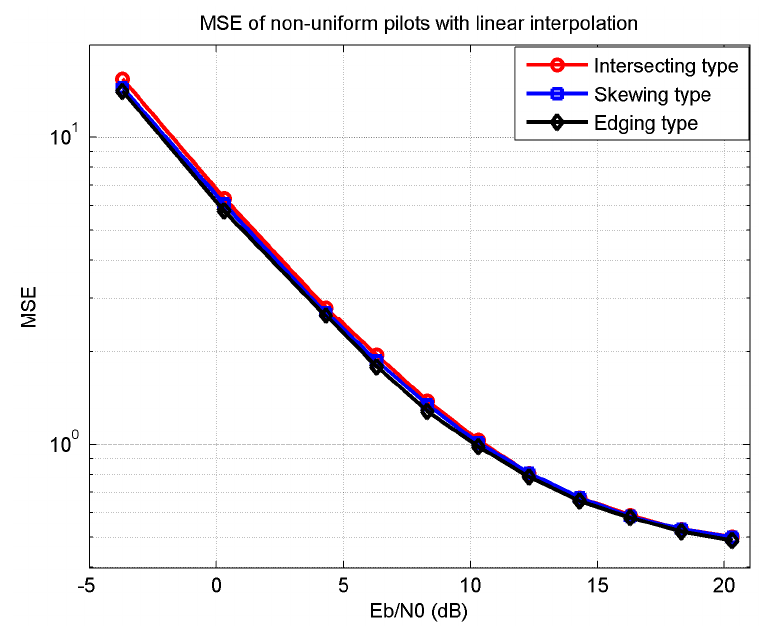
Figure 5. MSE of non-uniform pilots with linear interpolation.